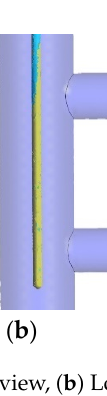
Figure 7. Internal temperature vessel, high-pressure section: ( a ) Longitudinal view, ( b ) Cross view.